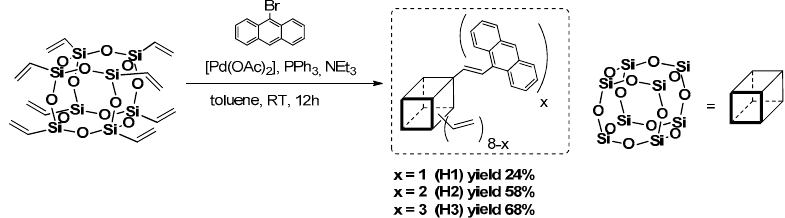
Figure 8. Heck coupling of OVS leading to mono-, di- and tri- anthracene-functional POSS. Their T d5% in the range of 407 °C (H3), 468 °C (H1) and 480 °C (H2), respectively, suggest high